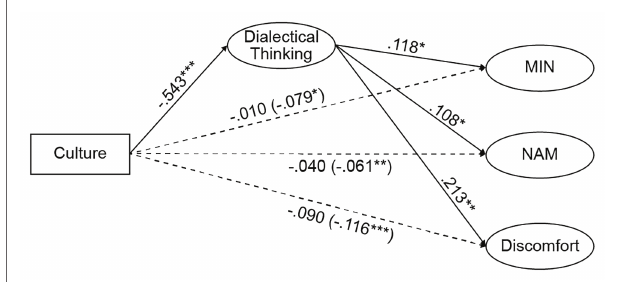
FIGURE 2 | Mediation scheme of dialectical thinking in the association between culture and mixed emotional experience (MIN, NAM, and discomfort) in the predominantly positive situation. Illustrated values depict the standardized path parameters of mediation model in predominantly pleasant situations. Chinese participants were coded as 0; American participants were coded as 1; culture served as the independent variable; dialectical thinking as the mediation variable; MIN, NAM, and discomfort in predominantly pleasant situation as the outcome variables; sex and age were control variables. Values in brackets depict the indirect effects of culture on three different predictors. * p < 0.05; ** p < 0.01; *** p <